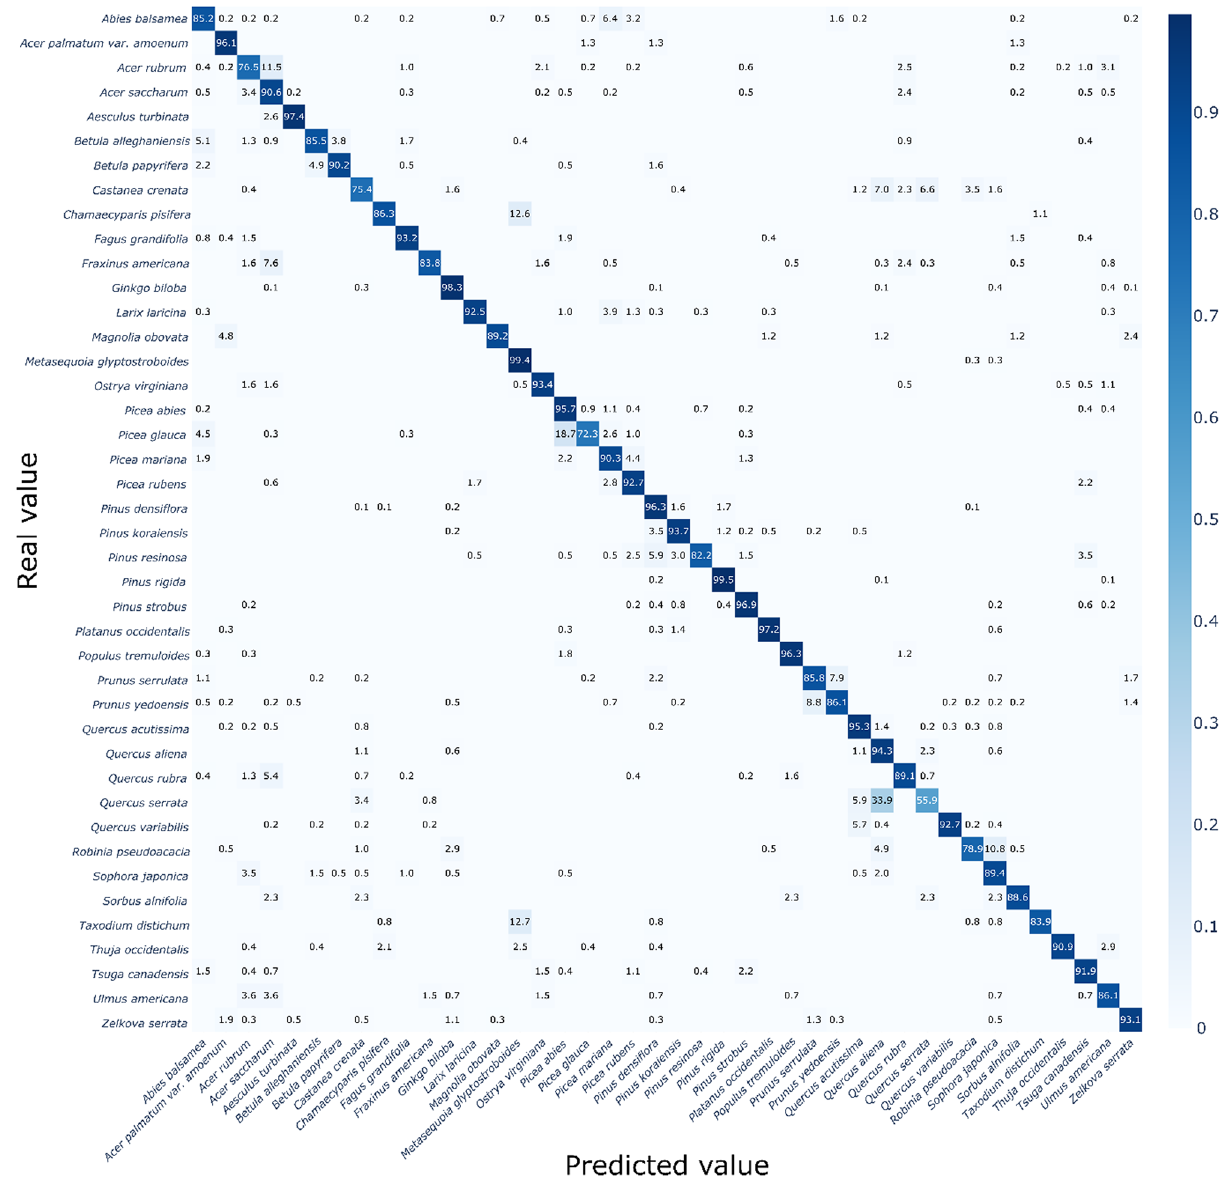
Figure 1. Confusion matrix of 42 species produced by VGG-16. The X- and Y-axis indicate the predicted class from the model and true label, respectively. The color of each cell represents the classification accuracy and actual accuracy values are written in each cell. Empty cells indicate the zero proportion, namely no prediction by the model. Detailed values for the figure are given in Supplementary data